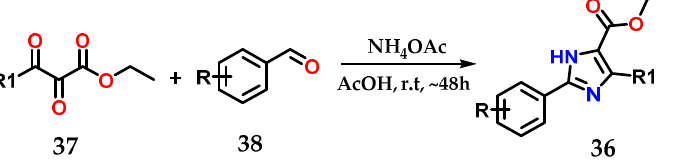
Figure 17. Obtaining 2,4,5-trisubstituted imidazoles 36 from 2,3-dioxo-3-substituted propanoates 37 . 2-Aryl-4,5-dicarbonitrile imidazole derivatives 39 could be obtained from the coupling of substituted aromatic aldehydes 40 and 2,3-diaminomaleonitriles 41 in the presence of a mixture of cerium (IV) ammonium nitrate/nitric acid (CAN: NA|0.05: 0.4 eq.) at 120 ◦ C for less than 1 h without using solvents (Figure 18) [30].